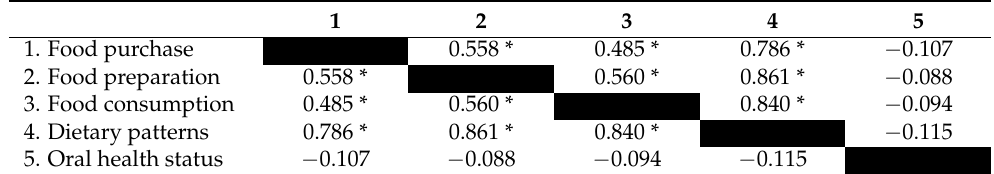
Table 2. Correlation matrix between food purchase, food preparation, food consumption, dietary patterns and oral health